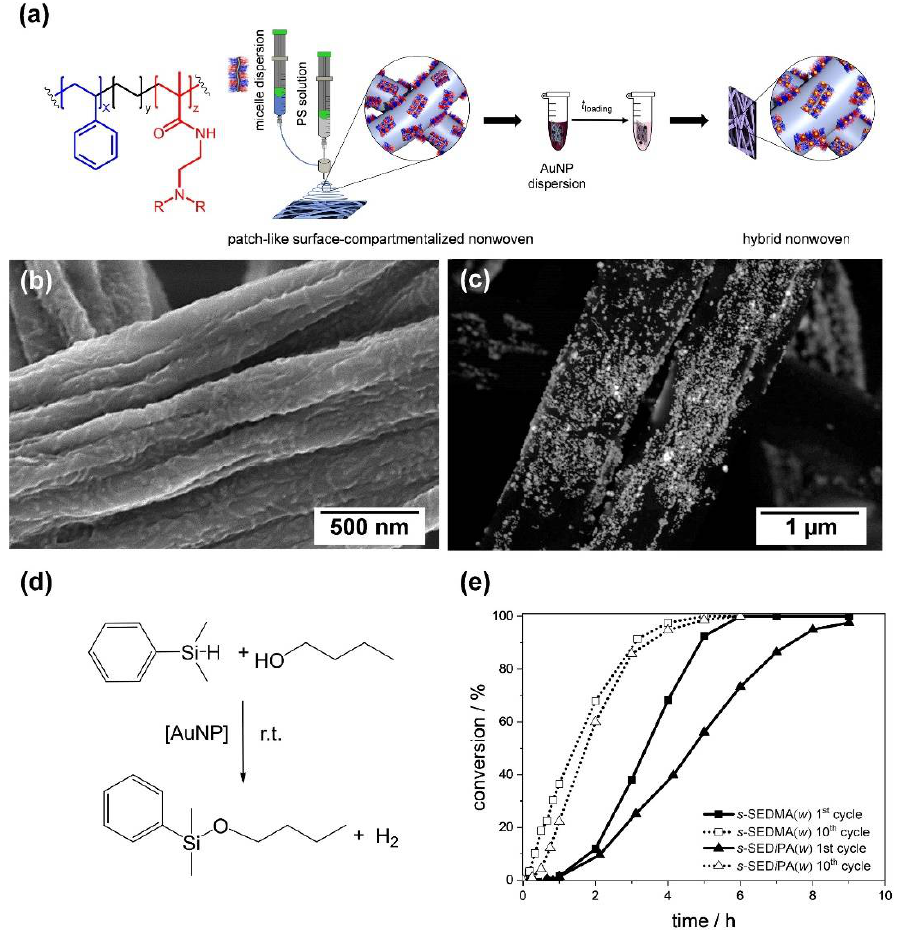
Figure 11. ( a ) Catalytically active, hybrid nonwovens prepared by a combination of bottom-up (CDSA) and top-down (coaxial electrospinning) approaches. In the first step, patchy nonwovens were prepared by decorating a PS nonwoven with functional, patchy PS– b –PE– b –poly(dialkylaminoethyl methacrylamide) wCCMs by coaxial electrospinning (PS patches are depicted in blue and the functional, tertiary amino group containing patches in red). Subsequently, the patchy nonwovens were loaded with citrate-stabilized Au NPs via a ligand exchange process (citrate against tertiary amino groups in functional patches). ( b ) Scanning electron microscopy images of a patchy nonwoven (based on S 415 E 830 DMA 420 wCCMs) before and ( c ) after loading with Au NPs (back-scattered electron detector). ( d ) Au NP-catalyzed alcoholysis of dimethylphenylsilane in n -butanol. ( e ) Kinetics of the Au NP-catalyzed alcoholysis of dimethylphenylsilane in n -butanol, employing patchy hybrid nonwovens as catalysts (D i PA = poly(di iso propylaminoethyl methacrylamide). Reproduced from [186] with permission from RSC.